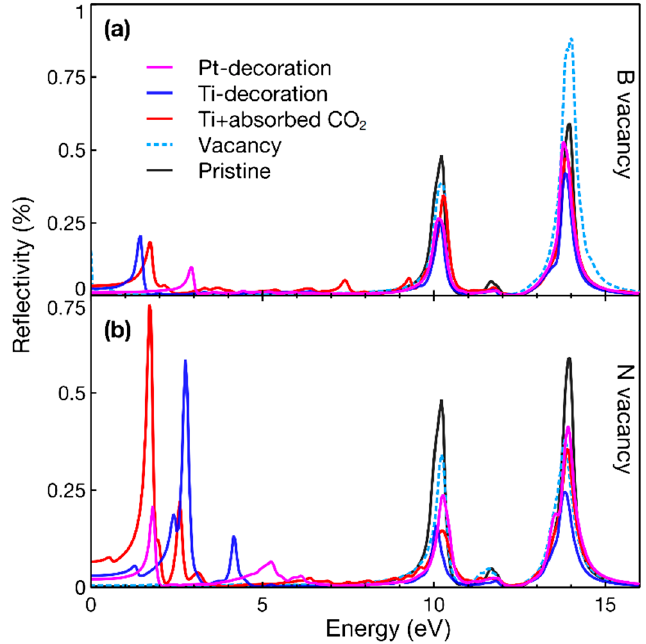
Figure 6. Reflectivity spectra. In ( a ) we see the cases with the B atom removed from the hBN surface, while in ( b ) we see those with the N atom removed. The effect of the Pt and Ti doping and the CO 2 interaction is particularly evident for the N vacancy hBN case.